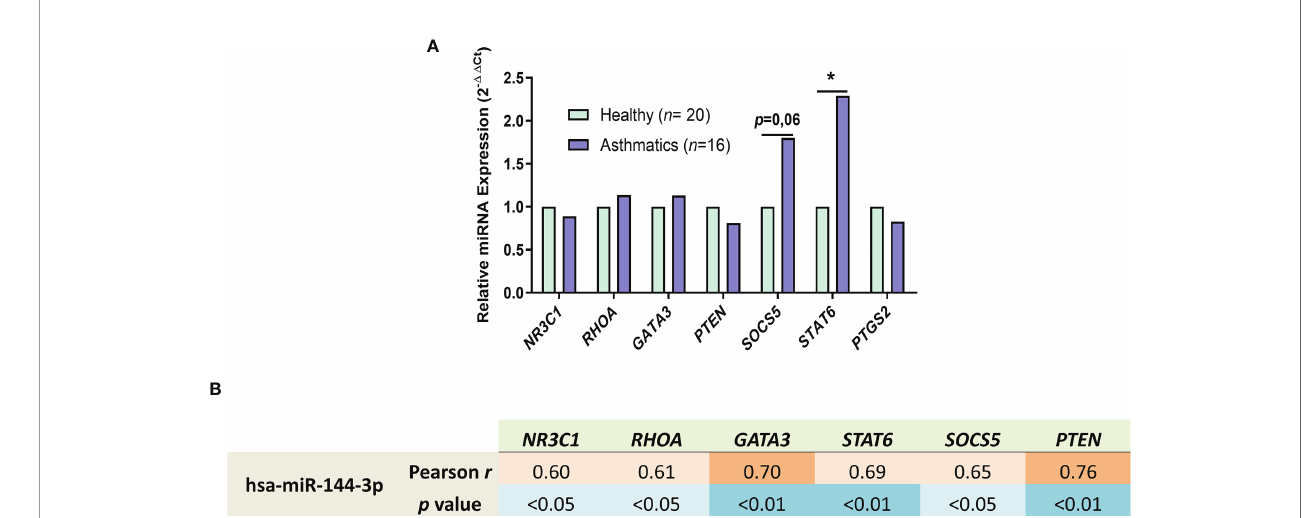
FIGURE 5 | miR-144-3p expression correlates with genes involved in asthma. (A) Relative mRNA – gene expression (2 - DD Ct ) in airway biopsies from asthmatics compared to controls. (B) Relative miRNA expression of miR-144-3p ( D Ct) in lungs of asthmatics directly correlates with the expression of asthma involved genes ( D Ct), as shown by Pearson r and p value of the Pearson correlation test. *p <